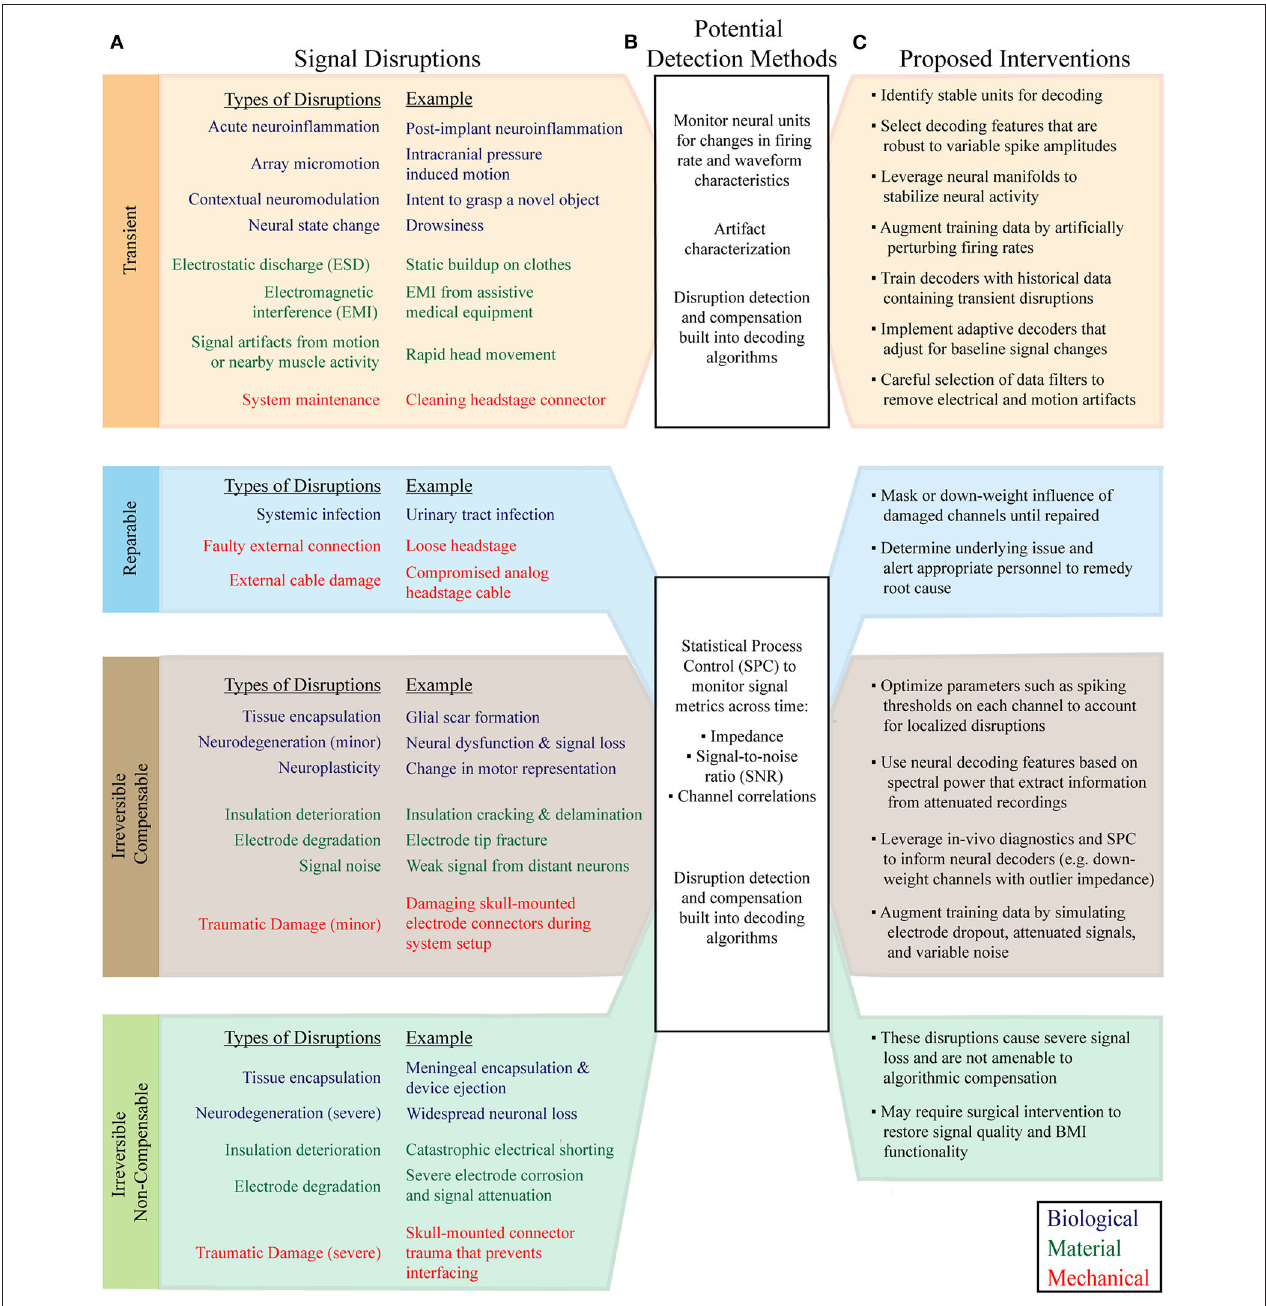
FIGURE 2 | Classification of common MEA signal disruptions and applicable compensatory strategies. (A) Signal disruptions are classified according to their underlying cause (Biological, Material, or Mechanical), and impact on signal quality and responsiveness to intervention (Transient, Reparable, Irreversible Compensable, and Irreversible Non-compensable). (B) Signal disruptions can be explicitly detected with statistical monitoring of neural features and recording metrics. Following the detection of a disruption, BMIs can initiate tailored algorithmic countermeasures to adapt to changes in signal characteristics. In parallel, advanced machine learning algorithms and decoder training strategies mitigate the effect of disruptions without requiring explicit detection. (C) The newly proposed disruption classes have characteristic interventions that help maintain BMI performance. Signal preprocessing, data augmentation, neural feature selection, neural manifolds, and adaptive neural decoders are among the most useful techniques for mitigating the effects of recording disruptions.